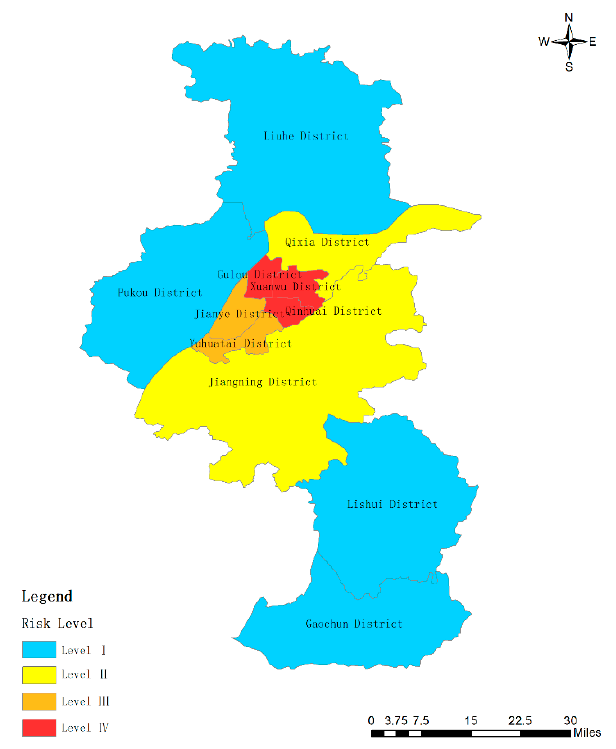
Figure 2. The levels of urban rainstorm risk levels in Nanjing.